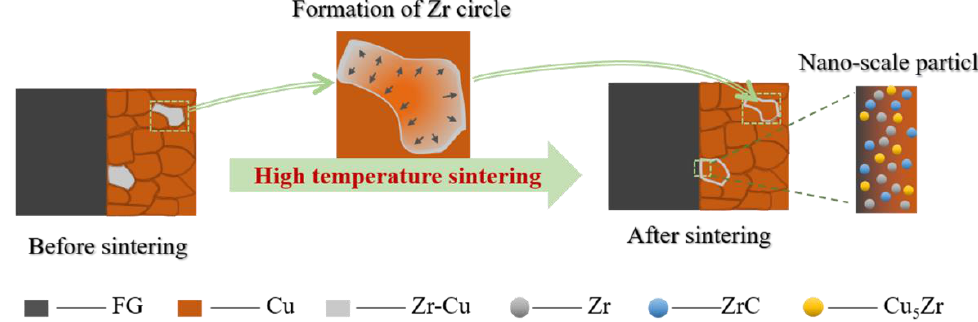
Figure 9. Morphological evolution of Zr in the FG/Cu composite.